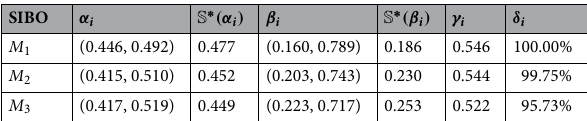
Table 14. The results of IF-COPRAS for SIBO assessment.